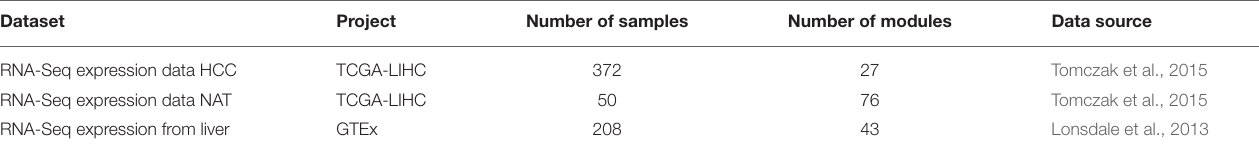
TABLE 4 | Details of datasets used in the case